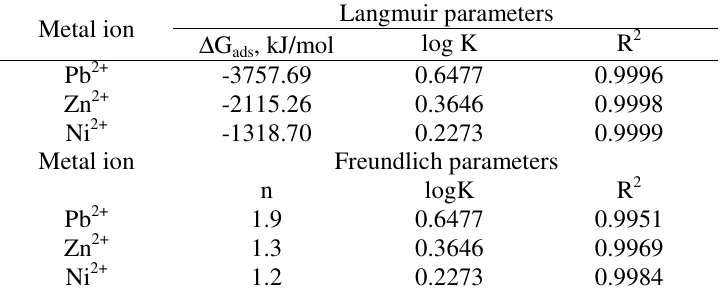
Figure 2 . Langmuir isotherm for the adsorption of Pb, Ni and Zn ions from aqueous solution by Helix aspera shell. Table 2. Langmuir and Freundlich parameters for the adsorption of Pb 2+ , Zn 2+ and Ni 2+ from aqueous solution by Helix aspera